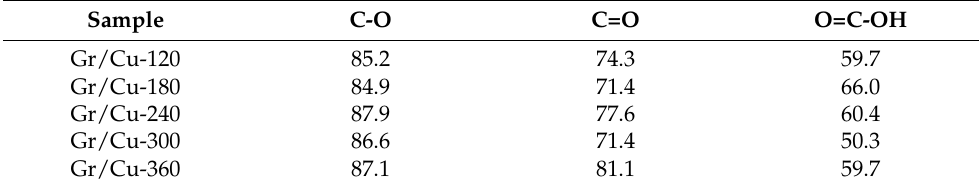
Table 3. The decreasing ratio of each bond type in Cu-Gr relative to GO